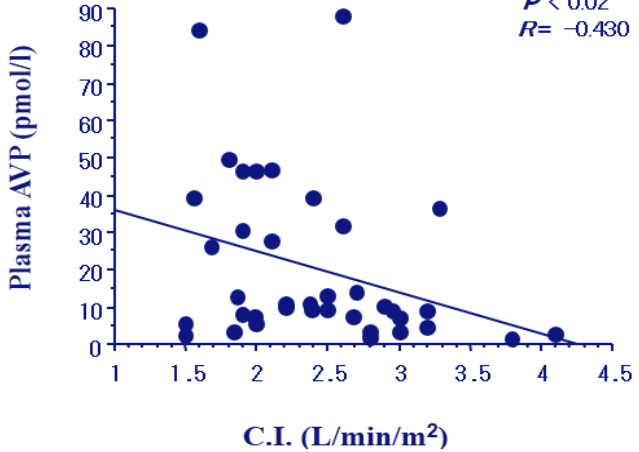
Figure 4. Negative correlation of plasma AVP levels with cardiac index (CI) in the patients with congestive heart